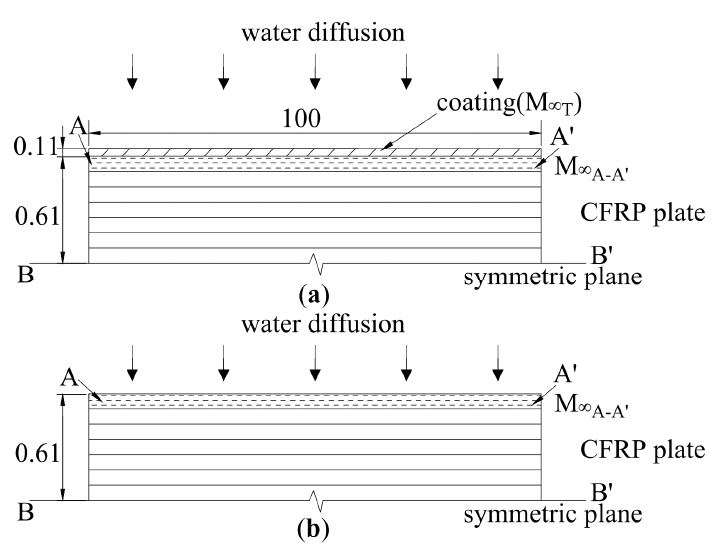
Figure 7. Cross-Section of ( a ) Coated CFRP plate; ( b ) Naked CFRP plate.